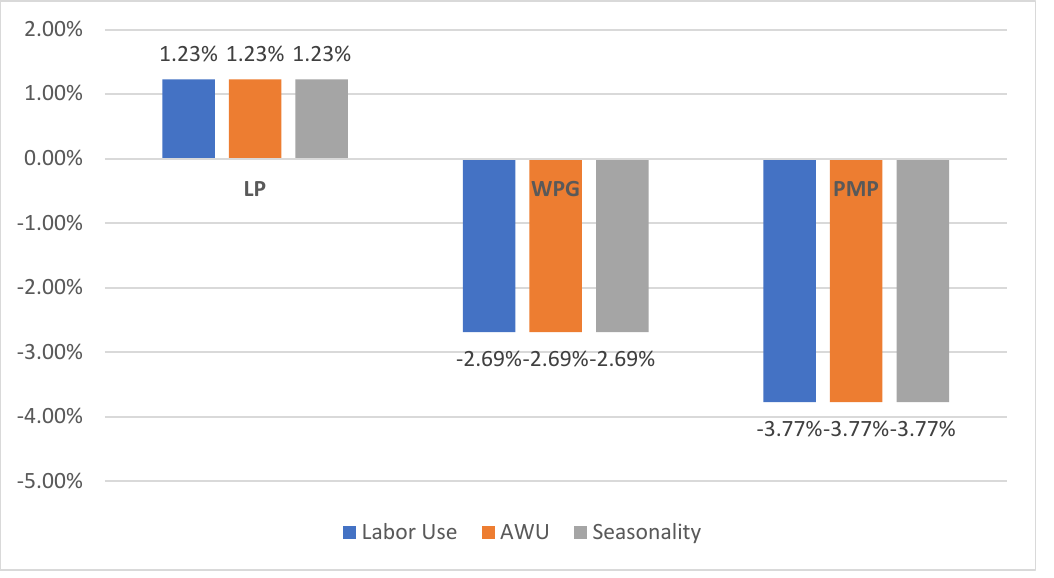
Figure 4. Changes in Social Indicators. Source: Our elaboration.